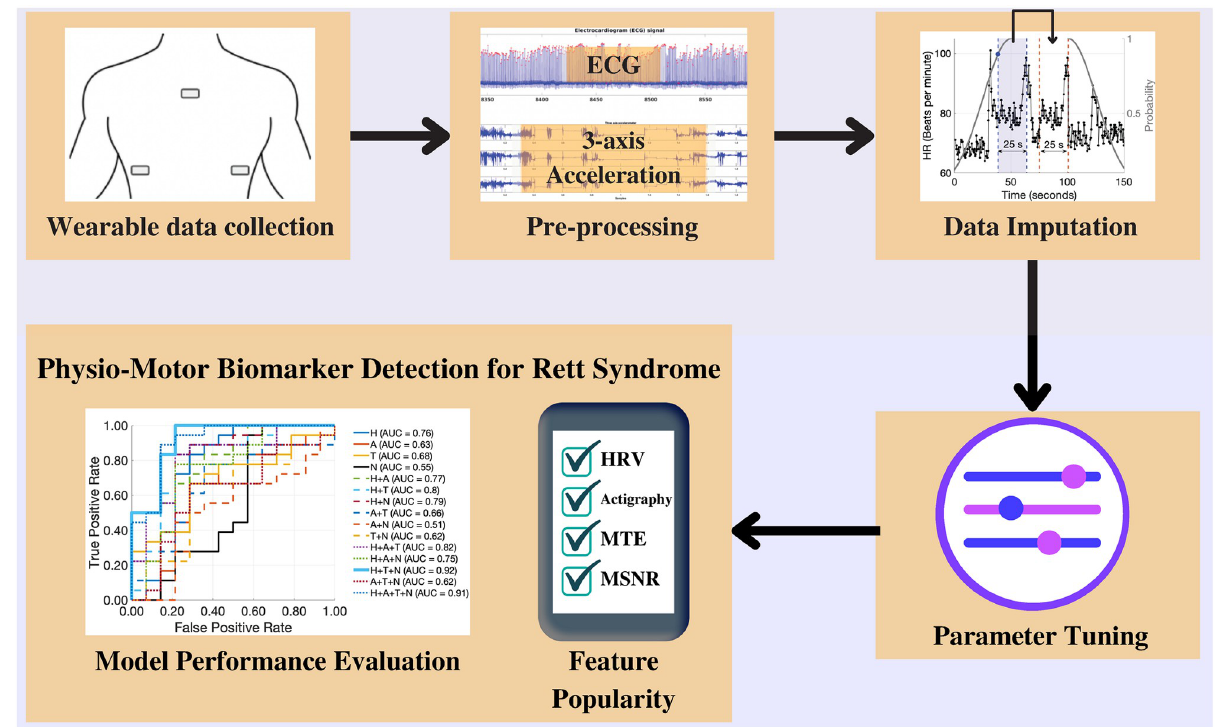
Fig 1. The project pipeline. We utilized the BioStamp 1 nPoint biosensor wearables to collect simultaneous ECG and three-axis acceleration data from multiple locations on the chest. We performed data pre-processing and implemented multiple data imputation techniques to improve data quality. We trained L1-regularized logistic regression classifier models and tuned the model weights using the imputed data. Finally, we visualized model performance and computed feature popularity scores.